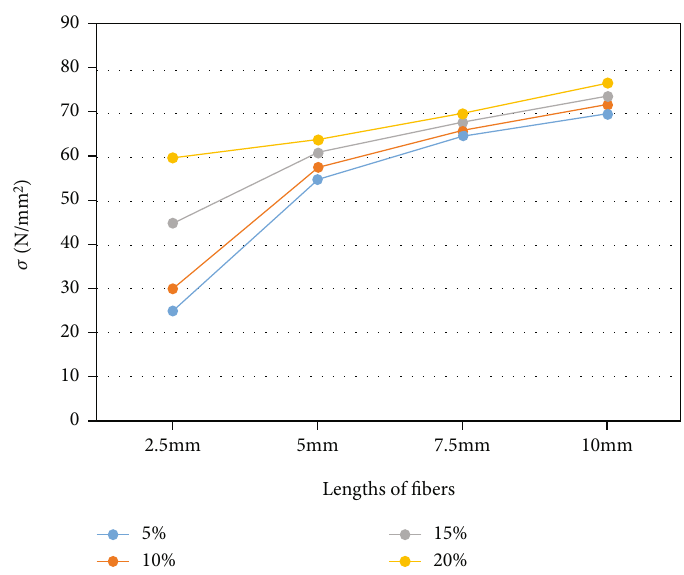
Figure 9: Tensile strength for di ff erent lengths and di ff erent weight ratios of DPF in the RP-DPF